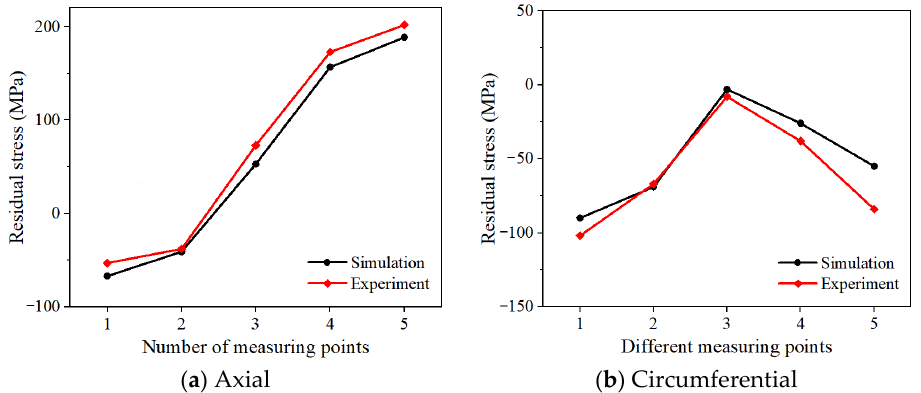
Figure 8. Comparison of experimental and simulated